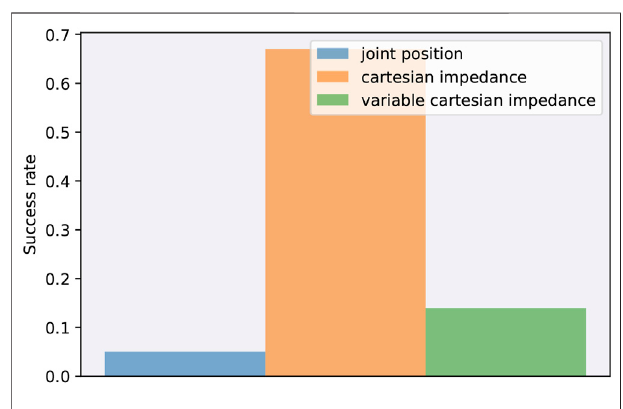
FIGURE 6 | Success rates when transferring a policy from simulation to reality with a random deviation of 5% from the initial joint positions q init .